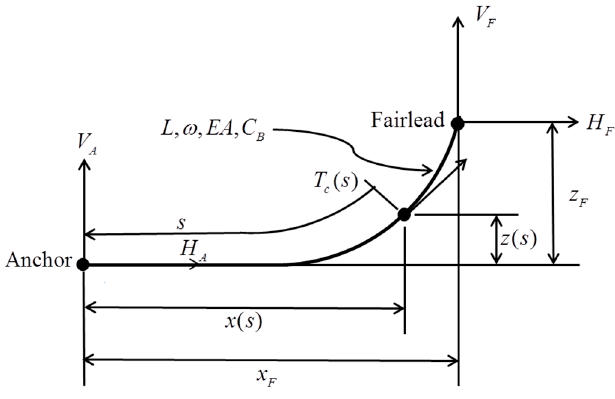
Figure 1. A single mooring line with undercover length in a local coordinate system.